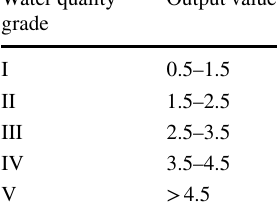
Table 1 Water quality grade and corresponding output value